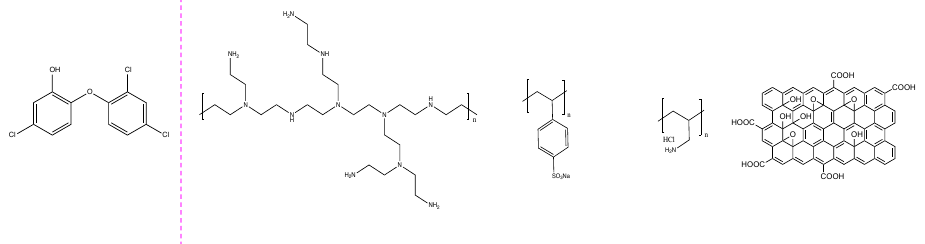
Figure 1. Chemical structure of triclosan and the polyelectrolytes: polyethyleneimine (PEI), poly (sodium 4-styrenesulfonate) (PSS), poly(allylamine hydrochloride) (PAH), and graphene oxide (GO).